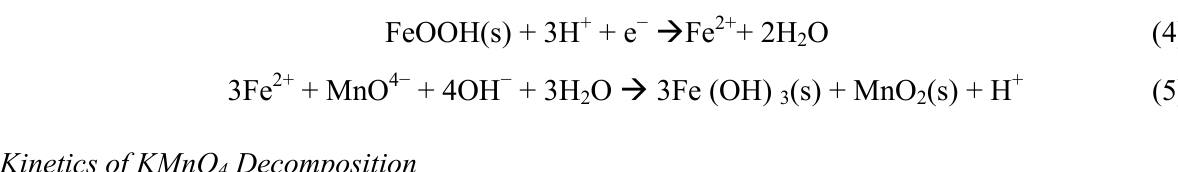
Figure 7. First-order fit of KMnO